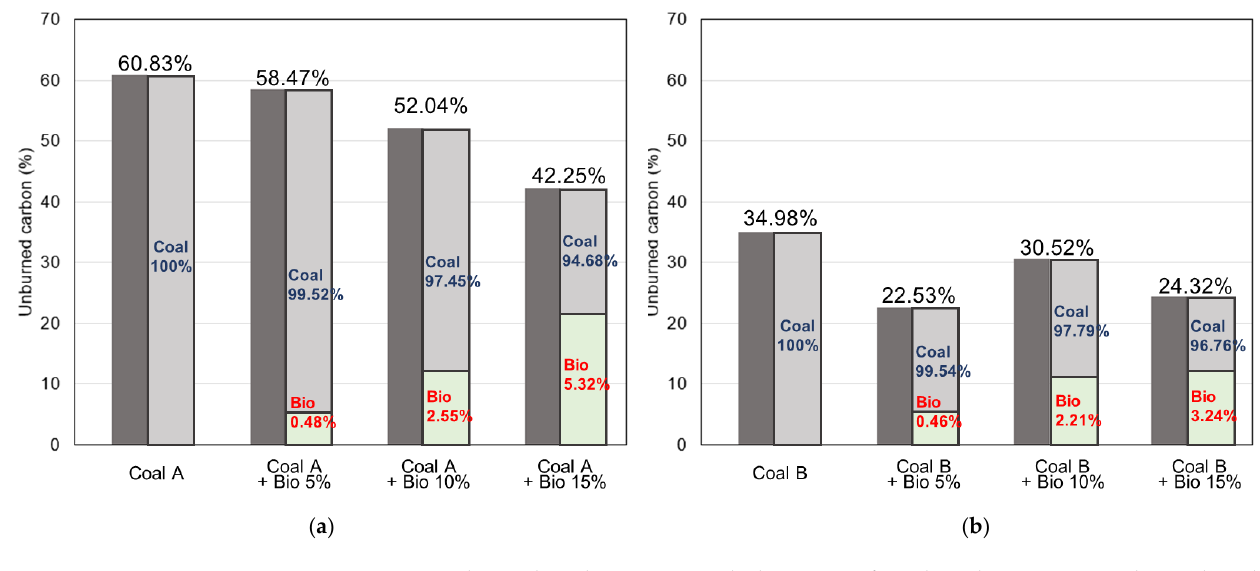
Figure 8. Unburned carbon ratio and the ratio of coal to biomass in unburned carbon ( a ) Coal A + biomass (0%, 5%, 10%, 15%) and ( b ) Coal B + biomass (0%, 5%, 10%, 15%) (The proportions of the coal–biomass shown in the plot were rescaled to show the tendency). Table 2. Radiocarbon dating results. Coal A (Balance, wt.%) Coal B (Balance,